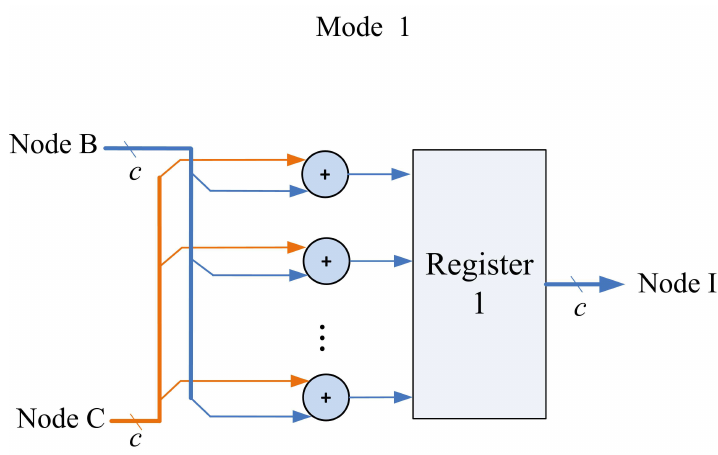
Figure 12. Four modes of matrix computation